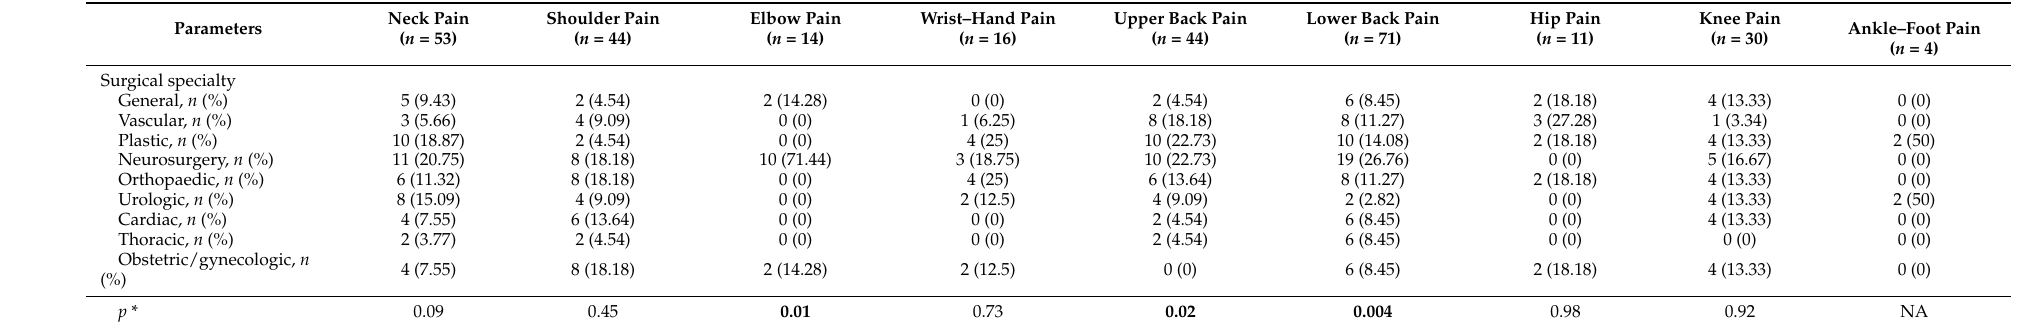
Table 3. Prevalence of WMSCs by surgical